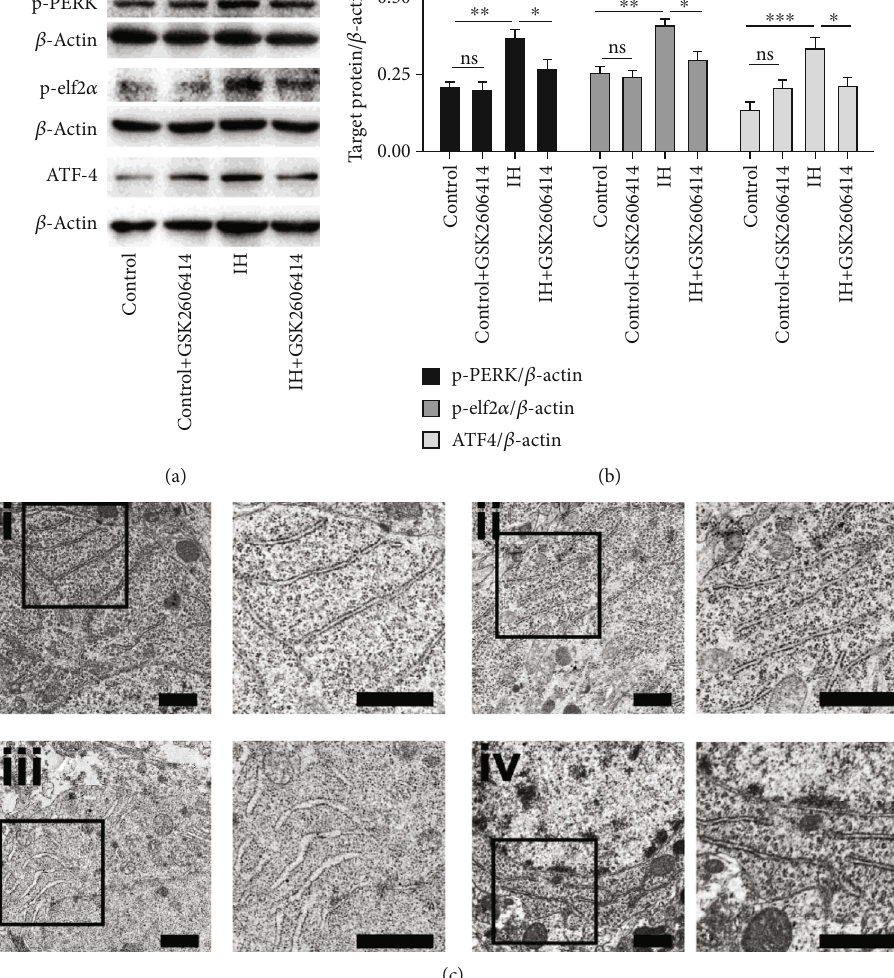
Figure 2: GSK2606414 inhibited the PERK pathway and rescued ER morphology. (a) Upregulation of p-PERK, p-elf2 α , and ATF-4 was reduced by GSK2606414 administration. (b) The pooled data from three mice in each group are summarized. (c) Clear and intact ER ultrastructure (indicated by arrowheads) was observed in the control group (i) and the GSK2606414 group (ii). However, 14 days of IH caused ER swelling and distortion, suggesting protein aggregation in the lumen (iii). GSK2606414 attenuated the injury to ER structure induced by IH treatment (iv). The inset in each picture is enlarged and displayed on the right. ∗ P < 0 : 05 ; ∗∗ P < 0 : 01 ; ns: not signi fi cant. Scale bars: 0.5 μ